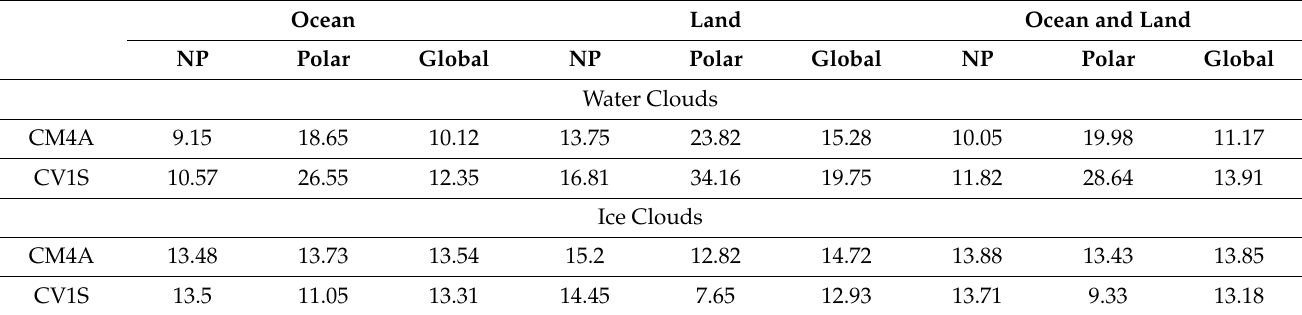
Table 5. Same as Table 2, except for the daytime mean cloud optical depths.